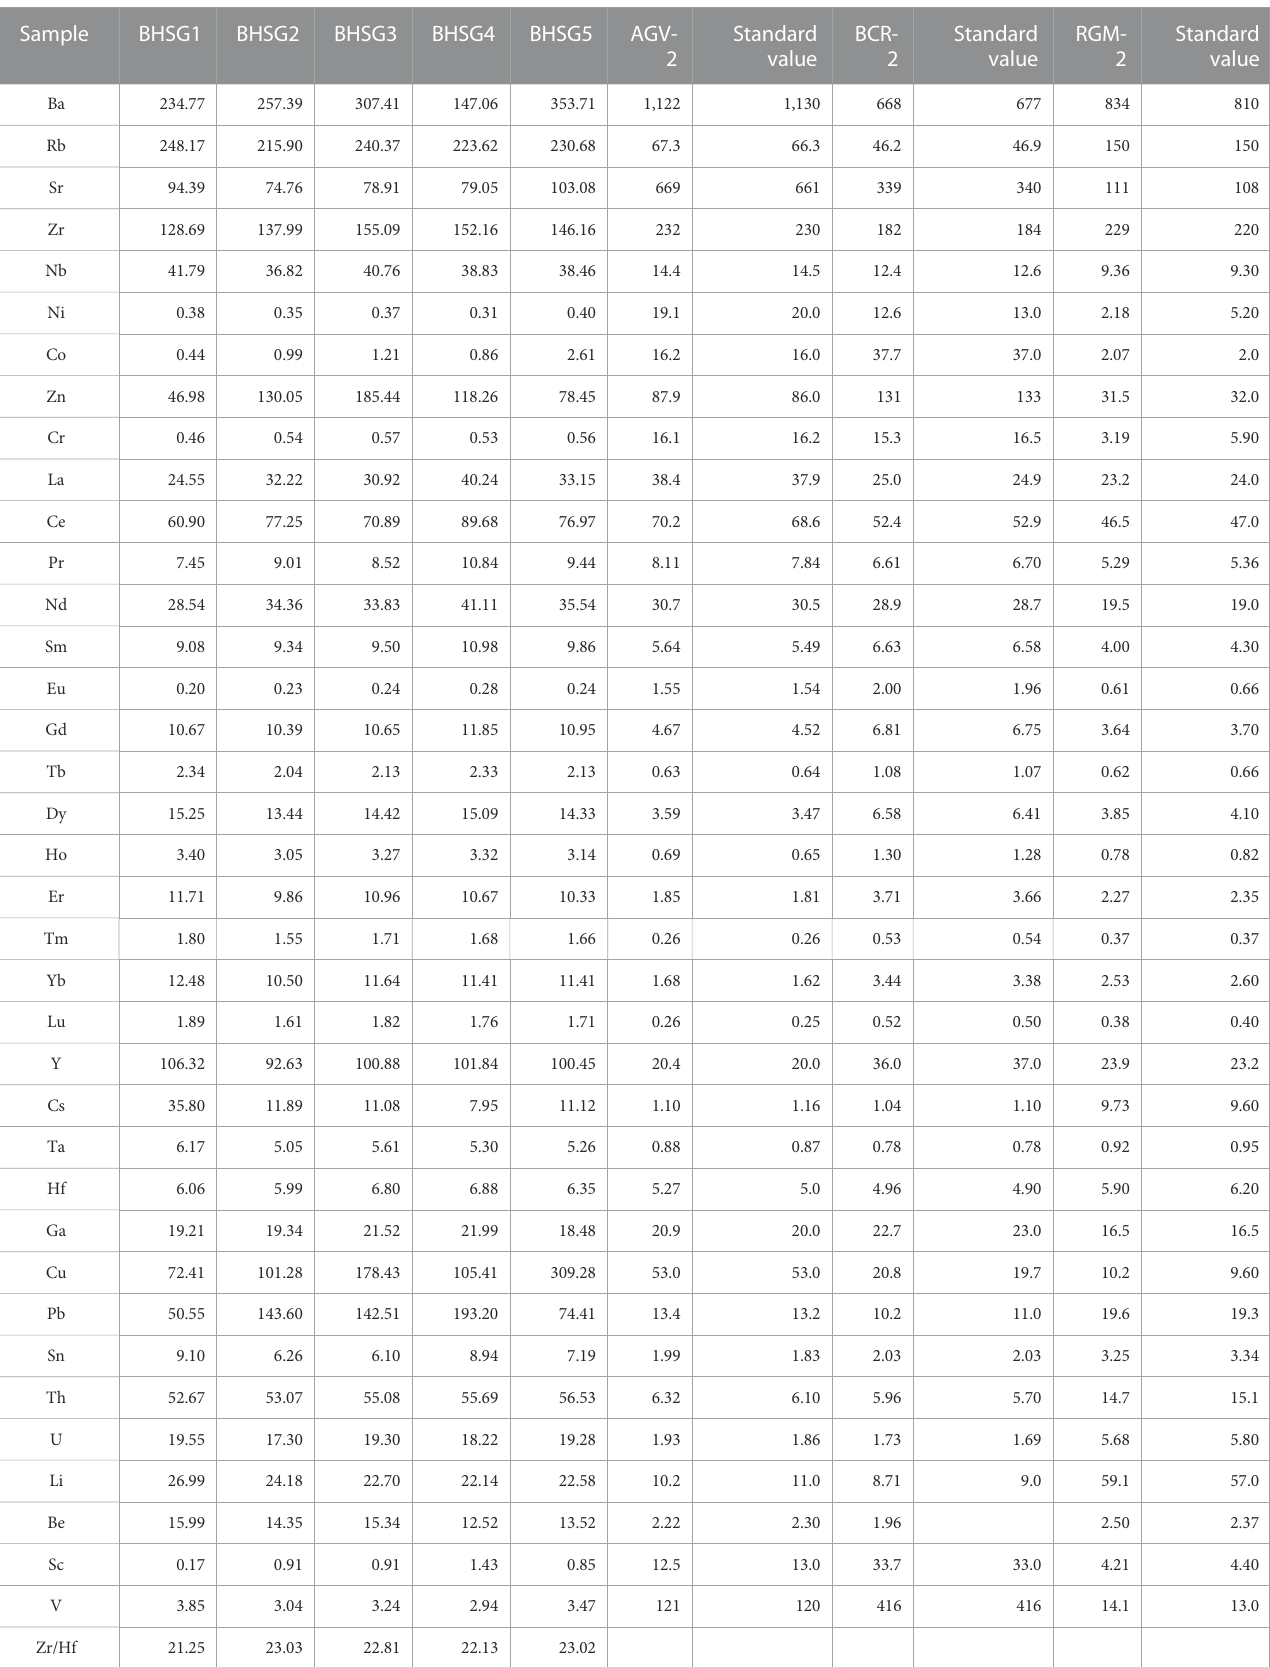
TABLE 6 Whole-rock trace-element composition of BHSG and standard samples.